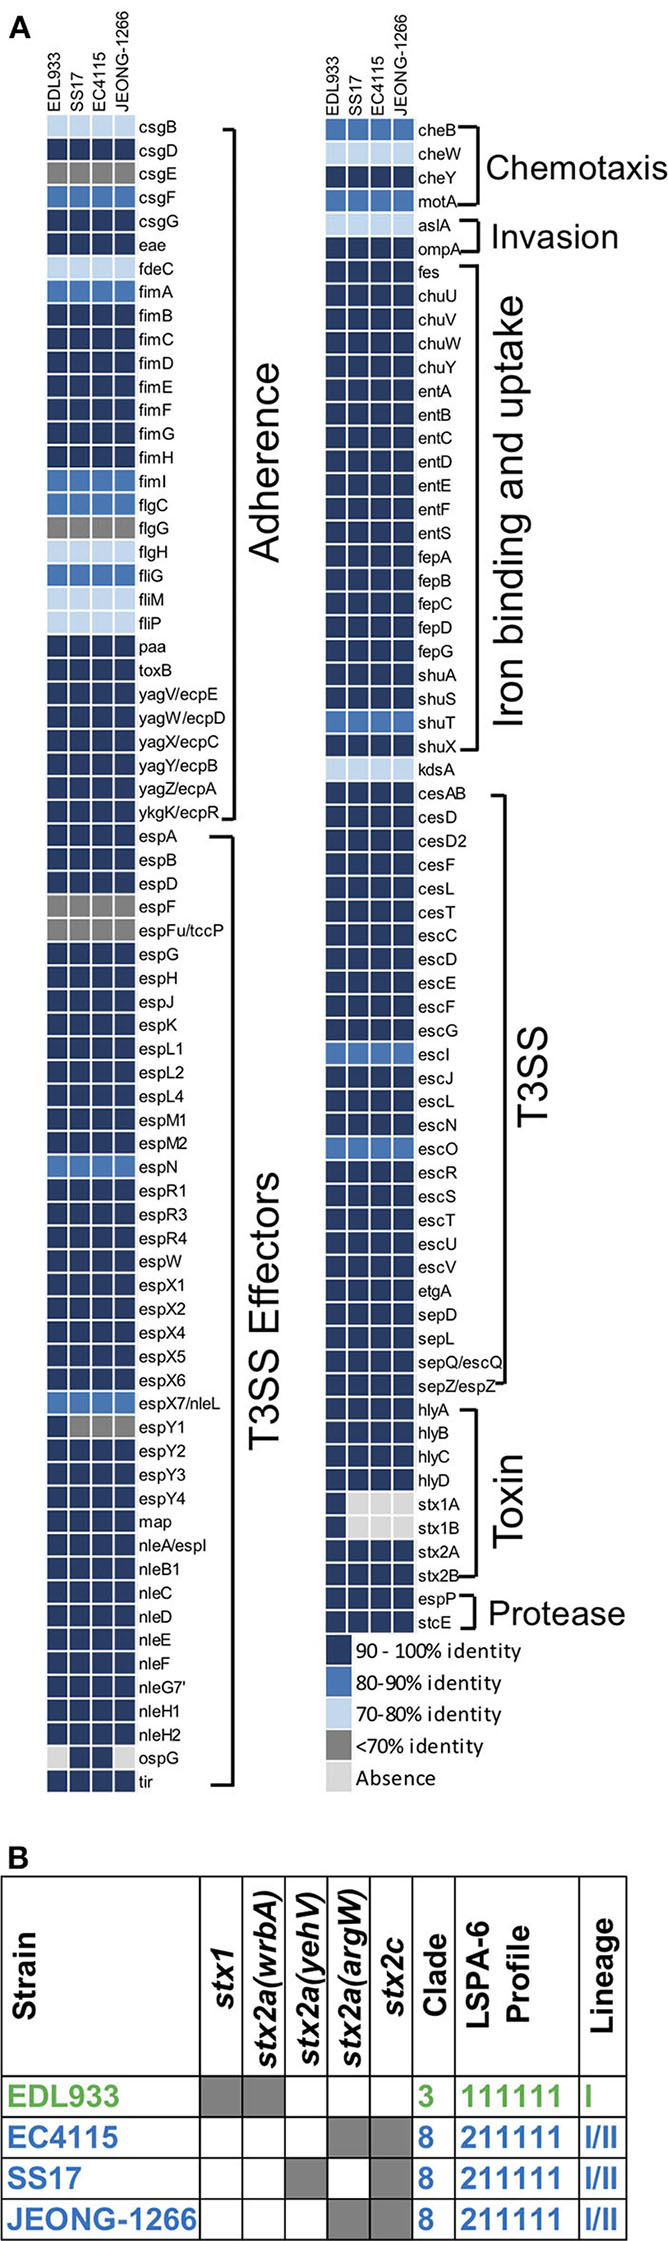
Virulence gene profiles and genotyping of E. coli O157. (A) Virulence gene profile of JEONG-1266 and other E. coli O157 strains, SS17, EC4115, and EDL933. The virulence genes of 4 strains were identified by aligning their CDSs against the protein sequences in VFDB by BLASTp. Compared with the sequences of virulence genes in VFDB, virulence genes in 4 strains showed distinct identities that were displayed using 5 color codes. (B) Genotyping of stx subtypes, clade, and lineage of JEONG-1266 and other STEC O157:H7 strains. A shaded gray box indicates the presence of the stx genes, and the insertion loci of the Stx2-encoding prophage.